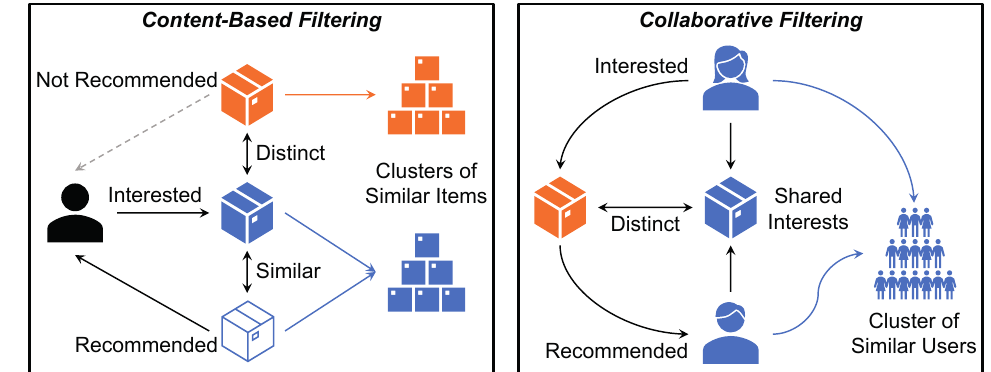
Figure 6. Two Fundamentally Different Modes of Operation of Recommender